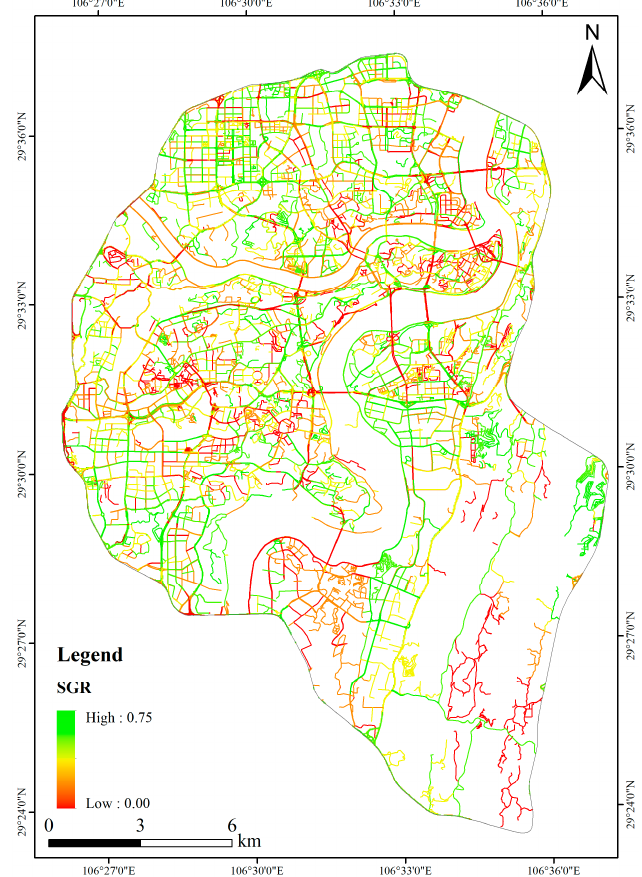
Figure 8. Spatial distribution map of SGR.